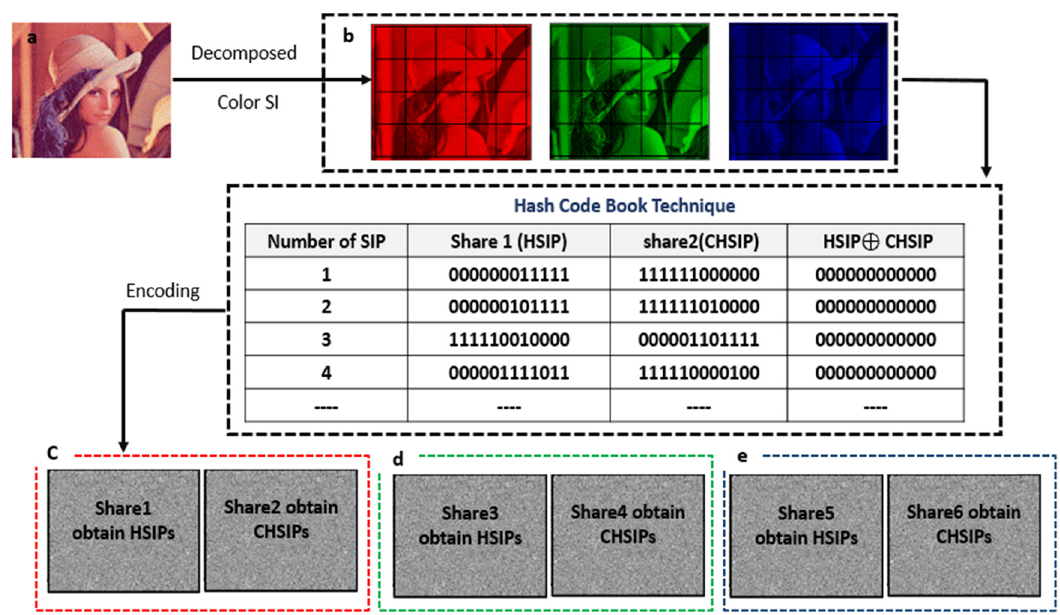
Figure 6: Generation of random shares hash codebook technique: ( a ) halftone SI, ( b ) R, G, B halftone SI, ( c ) shares 1 and 2 for red halftone secret image SI, ( d ) shares 3 and 4 for green halftone secret image SI, and ( e ) shares 5 and 6 for blue halftone secret image SI.